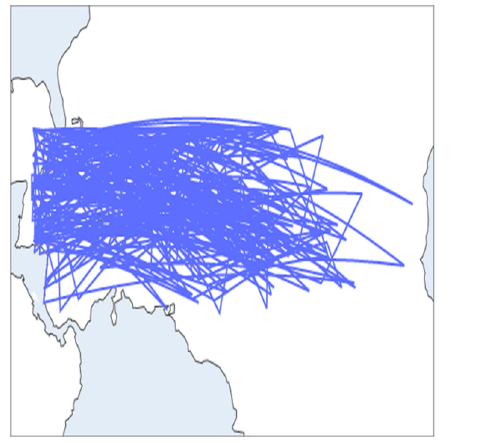
Figure 2. ( a ) Density of occurrence of storm; ( b ) point-wise density of occurrence of storm.